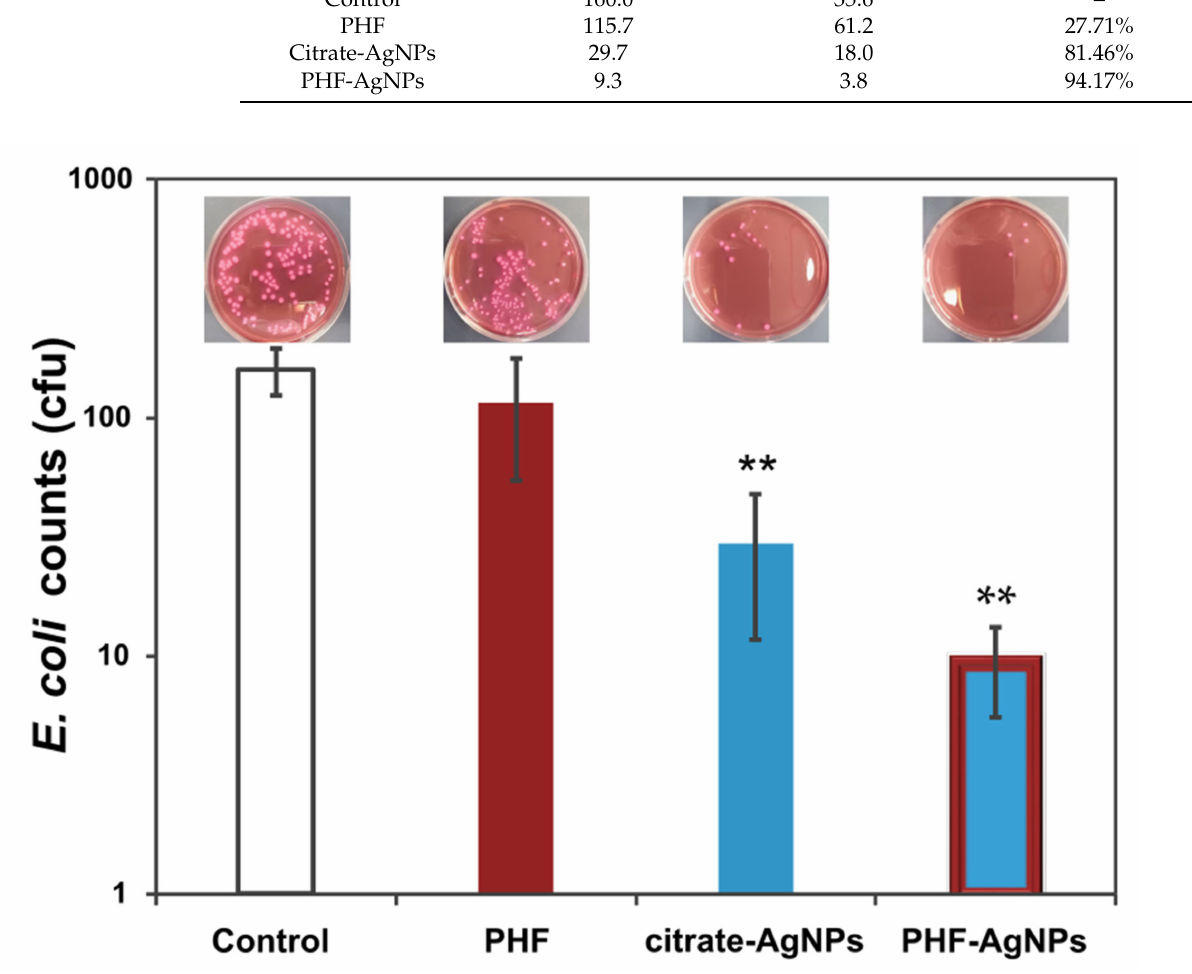
Figure 2. Examples of colony-forming units of E. coli in agar plates untreated (control) and